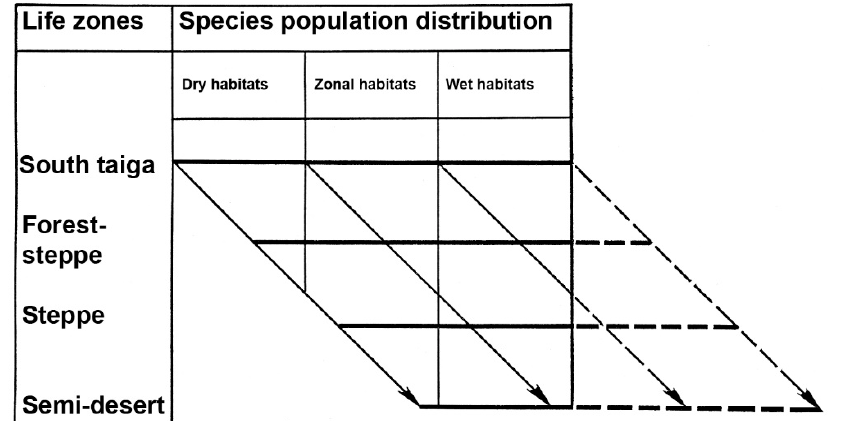
Figure 2. Bey-Bienko’s scheme of the zonal shifting of habitats (after [68]). The analysis of population distribution within the Eurasian steppes showed that the boundary between the steppe per se and the semi-deserts is significant in demarcating parts of population systems of many species. The frontier between the semi-desert and the northern deserts is also important.